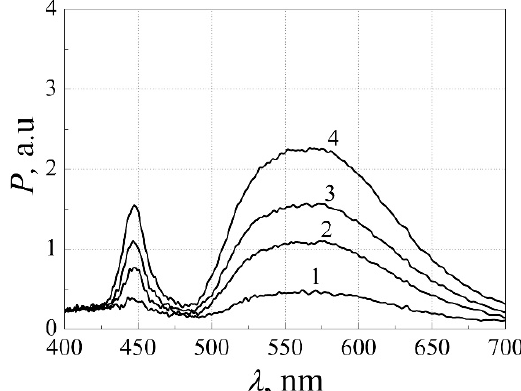
Figure 12. Optical spectra of the high-power white AlInGaN LED at forward currents I , mA: 1–20.9; 2–55.5; 3–86.4; 4–141.3 after 8000 h of aging. Reprinted with permission from [26]. 2–55.5; 3–86.4; 4–141.3 after 8000 h of aging. Reprinted with permission from